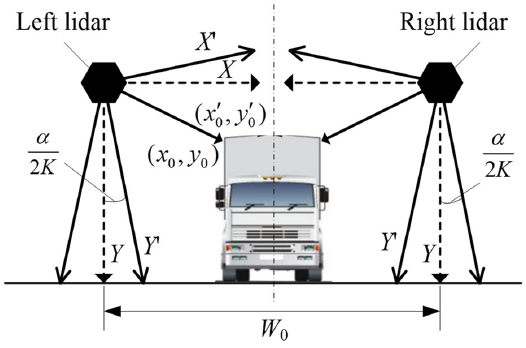
Figure 11. The influence of calibration error on vehicle width measurement.